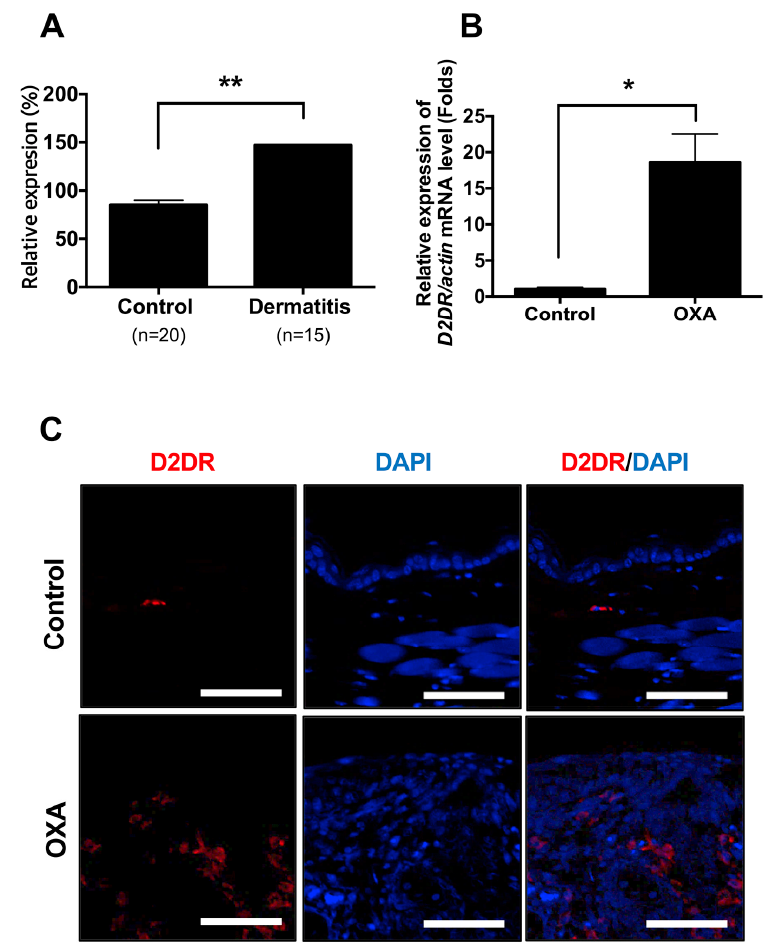
Figure 1. The expression levels of dopamine receptor D2 are increased from dermatitis patients and animal model of dermatitis ( A ) Expression levels of dopamine receptor D2 in normal ( n = 20) and dermatitis patients ( n = 15). ( B ) mRNA levels of dopamine receptor D2 (D2DR) from OXA-treated mice. Data are presented as mean ± SEM and analyzed by student t -test. * p < 0.05 and ** p < 0.01 vs. control. ( C ) Immunofluorescent analysis of dopamine receptor D2 (D2DR) from control and oxazolone-treated mice ear. Scale bar = 60 µ